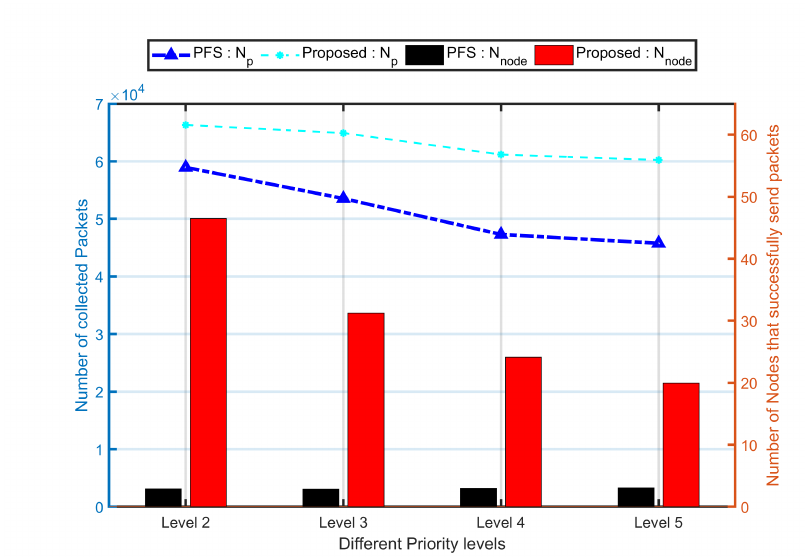
Figure 6. Impact of priority area change. In these simulations, the proposed algorithm is the combination of proposed Balance and prioritized-based contact-duration frame selection mechanism (PCdFS)